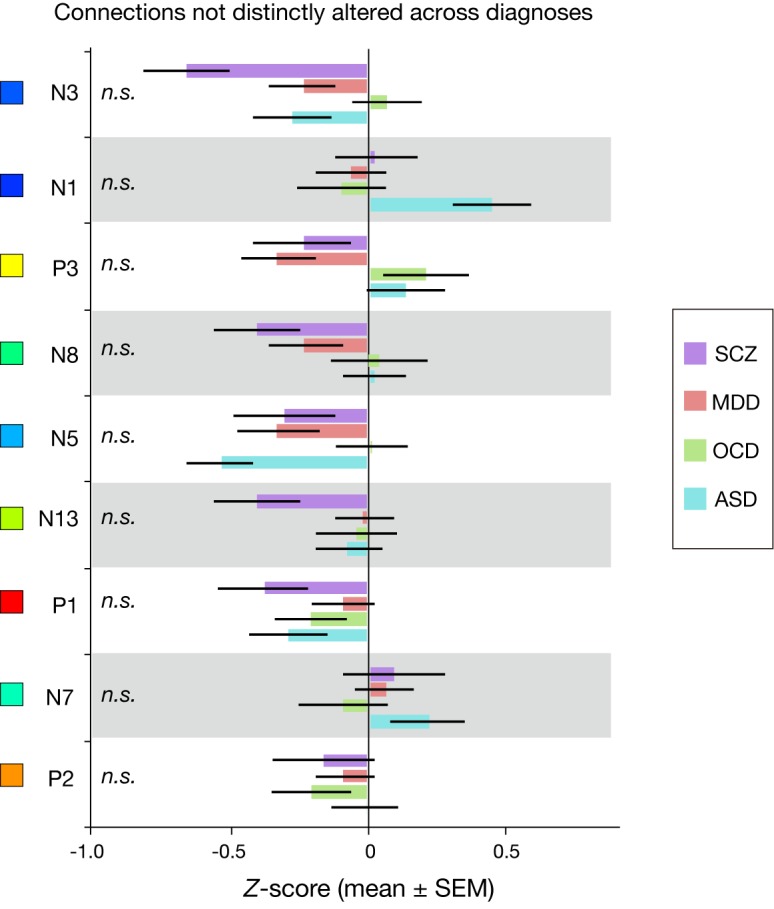
Connections of non-significant effect of diagnosis.